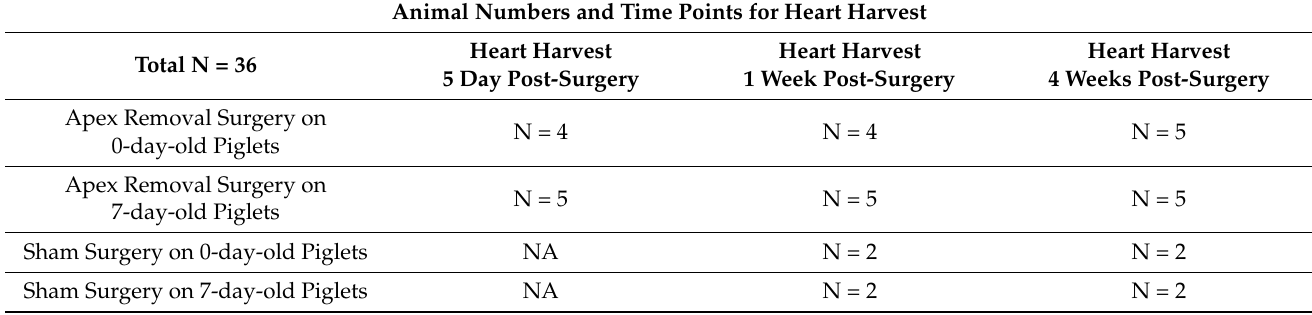
Table 1. Experimental layout for assessing the regenerative potential of neonatal pig hearts. Animal Numbers and Time Points for Heart Harvest Heart